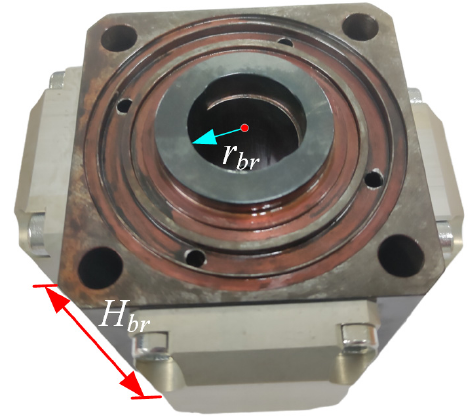
Figure 5. The rear hydrostatic bearing.